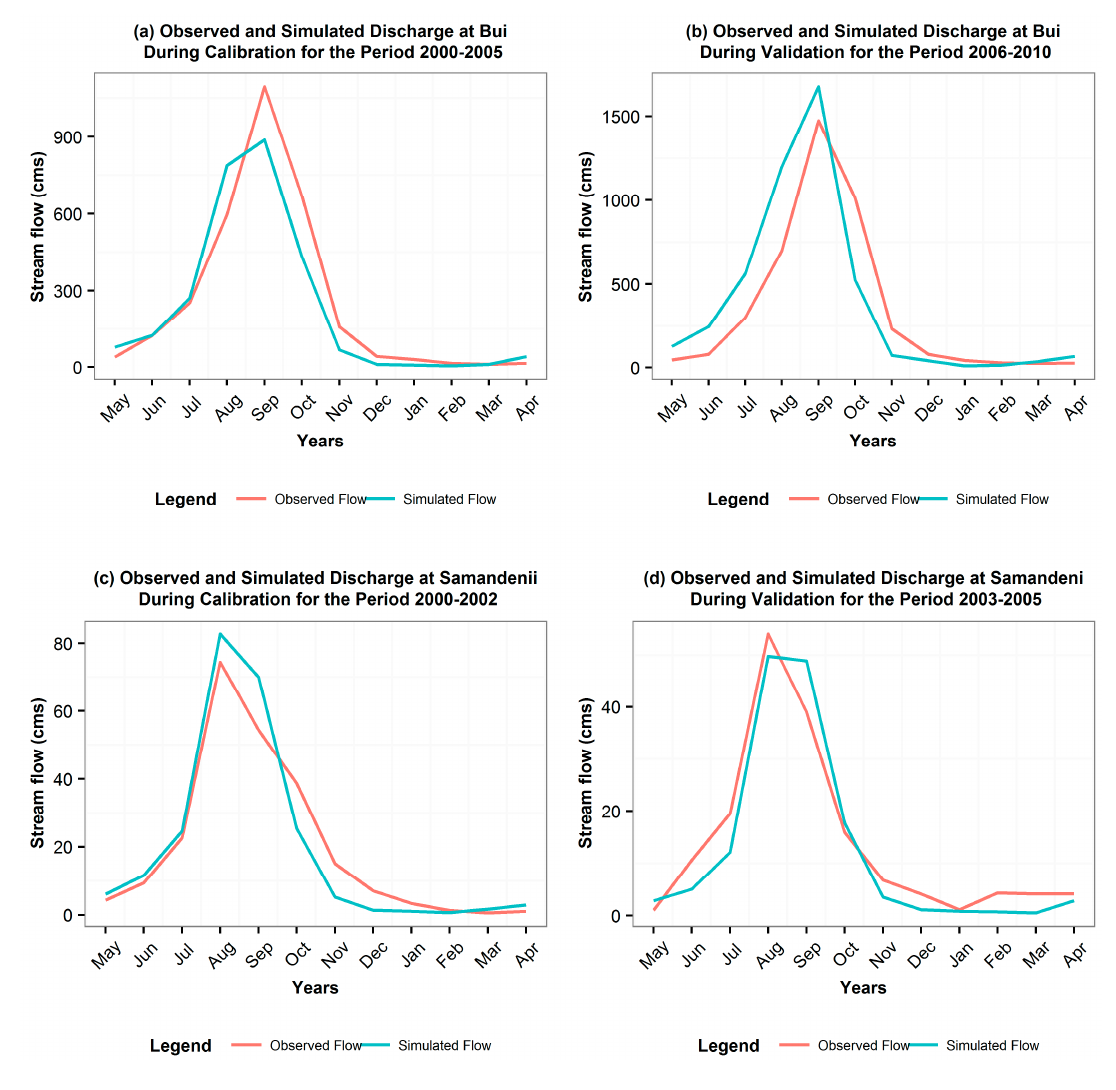
Figure 6. Calibration and Validation. Table 4. WEAP model performance